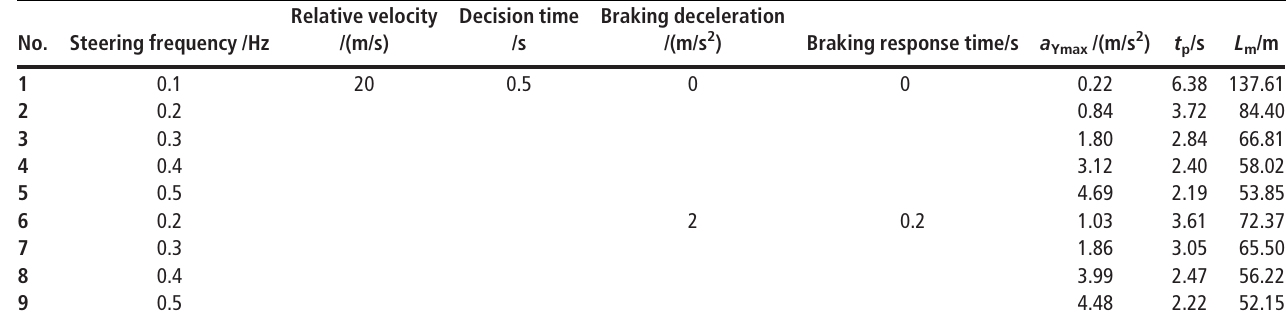
Table 3 Four-level lane changing modes for anti-collision Steering Mode